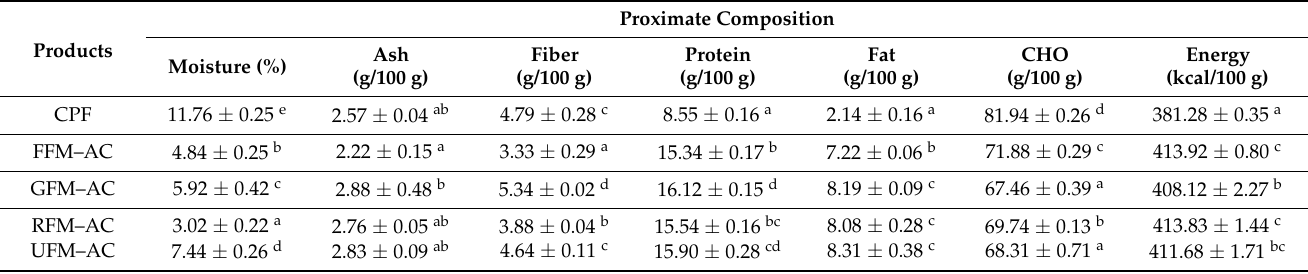
Table 1. Proximate and energy values of porridge flour on a dry weight